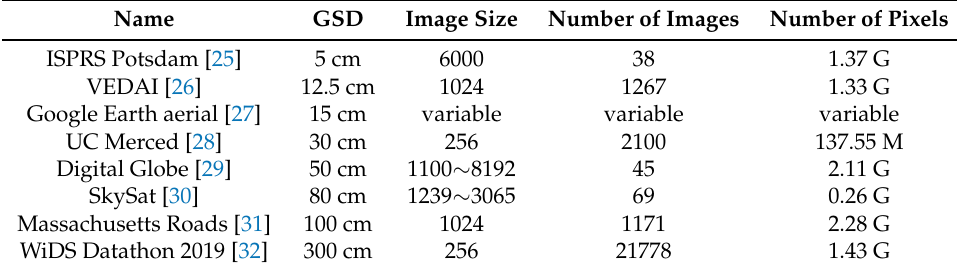
Table 1. Remote sensing image datasets with fixed